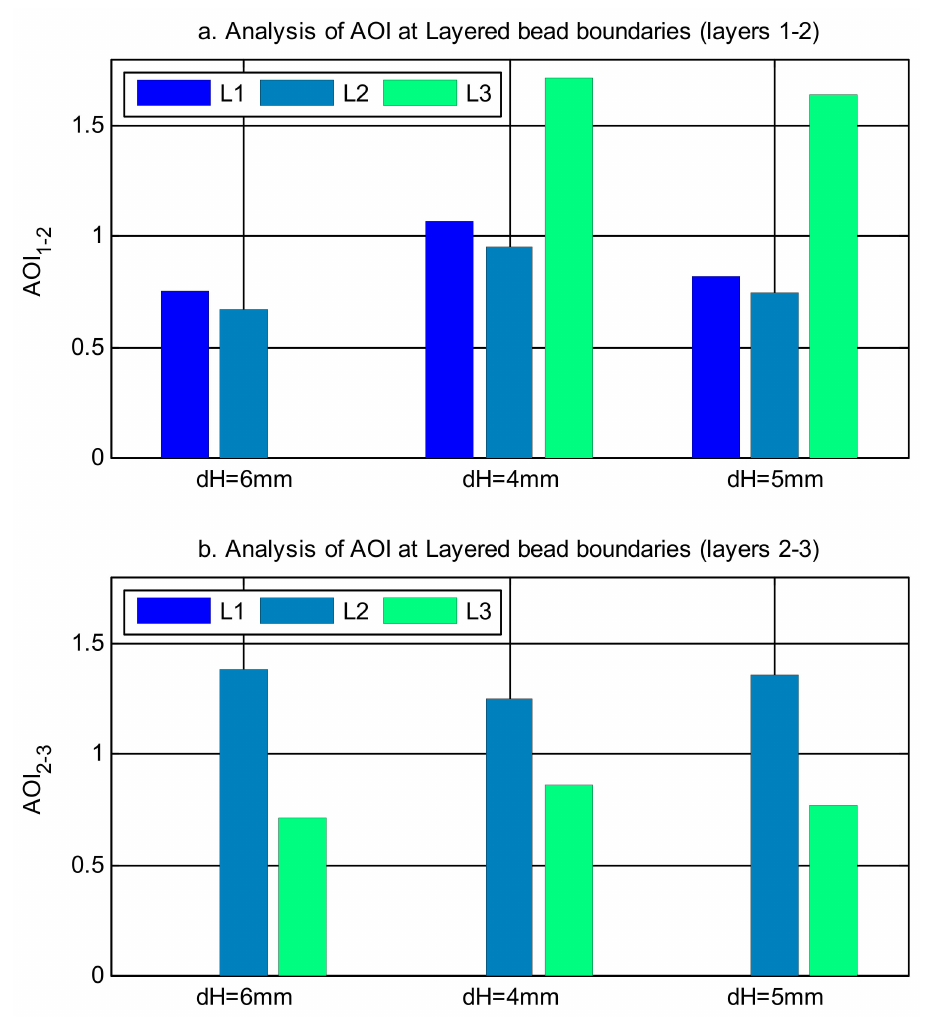
Figure 12. Experimental steady-state AOI ratios across bead layer boundaries for the Layered cases at head differences, dH = 6 mm, 4 mm, and 5 mm. (( a ) layers 1–2, ( b ) layers